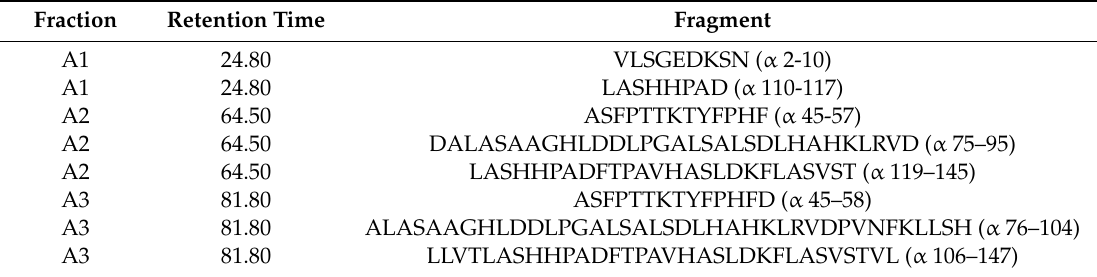
Table 2. Mass spectrometry data database search ( α chain results). Fraction A1 (eluted at 24.8 min) has two peptides corresponding to the fragments 2–10 and 110–117 of the hemoglobin α chain. Fraction A2 (eluted at 64.5 min) has three peptides corresponding to the fragments 45–57, 75–95 and 119–145 of the hemoglobin α chain. Fraction A3 (eluted at 81.8 min) has three peptides corresponding to the fragments 45–58, 76–104 and 106–147 of the hemoglobin α